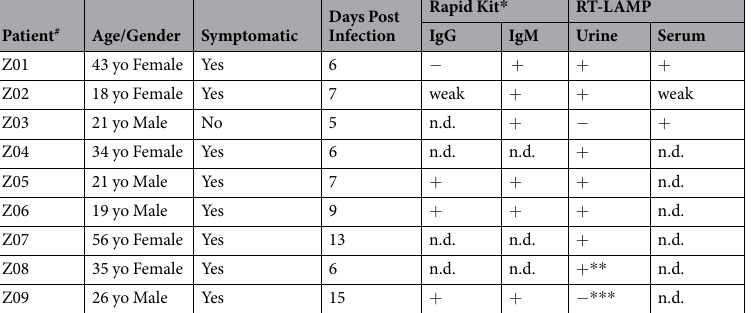
Table 1. Clinical samples positive for Zika Virus. n.d. is not determined. * Rapid Kit IgG and IgM testing results reported by Antibody Systems, Inc. ** Only after RNA isolation. *** Also not detectable by qRT-PCR with RNA